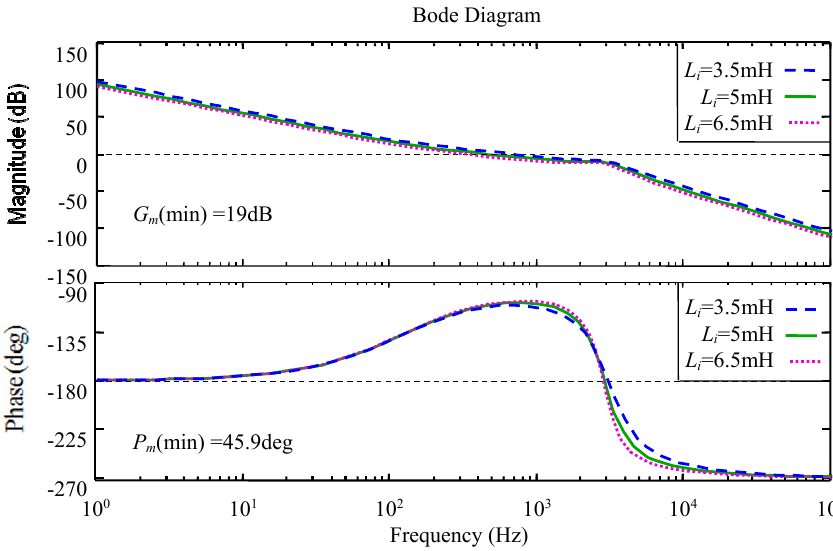
Figure 8. Pole map of the closed-loop system when L g varies from 0 to 13 mH.